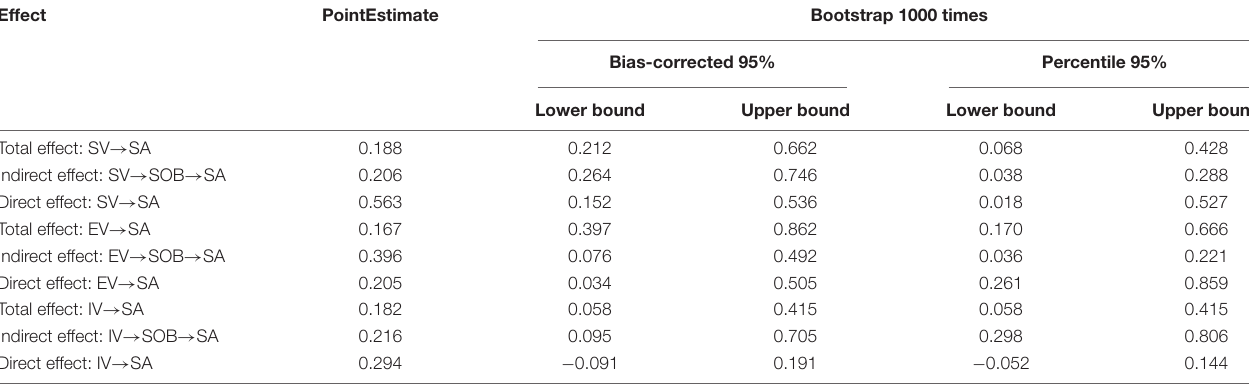
TABLE 5 | The analysis of mediation